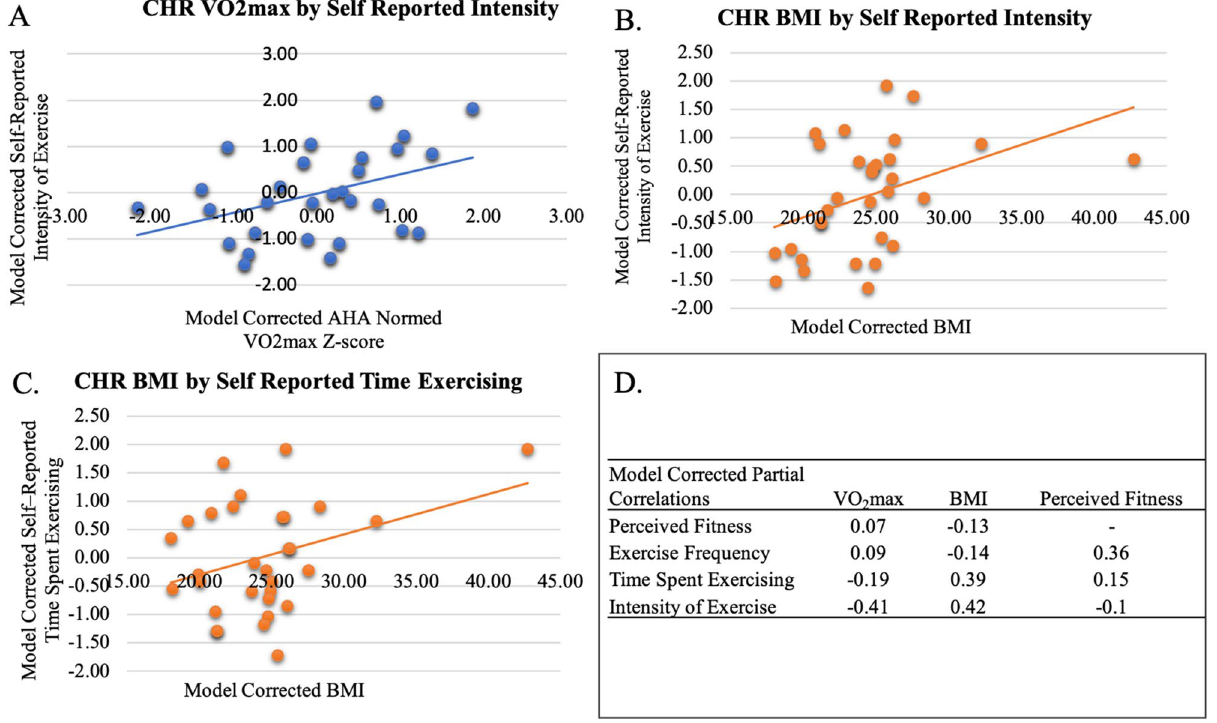
Figure 2. Relationship of objective physiological health to self-reported measures of fitness: (A) Within the CHR group relationships between VO 2 max to reported exercise intensity, (B) BMI to reported exercise intensity, (C) BMI to reported time spent exercising, (D) intercorrelation matrix of the perceived and actual fitness